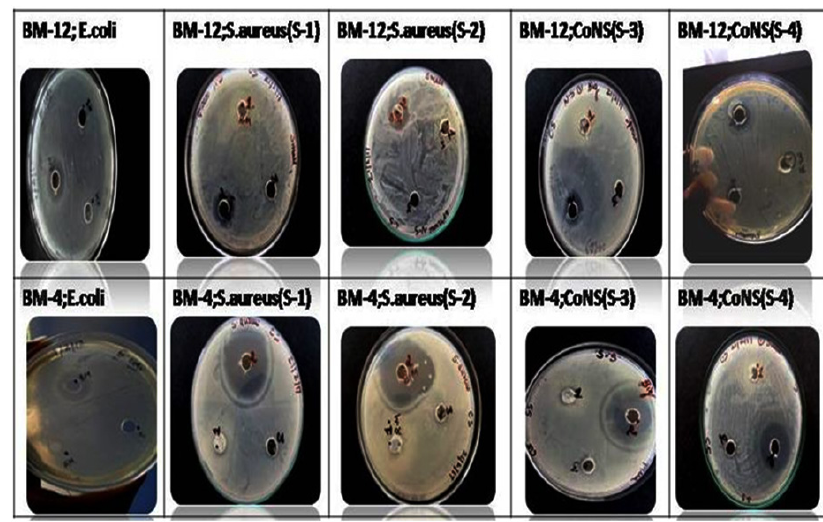
Fig. 3. Pictoral representation of anti-bacterial effect of two types of breast milk i.e BM-12 (late lactation) and BM-4 (early lactation) against five test